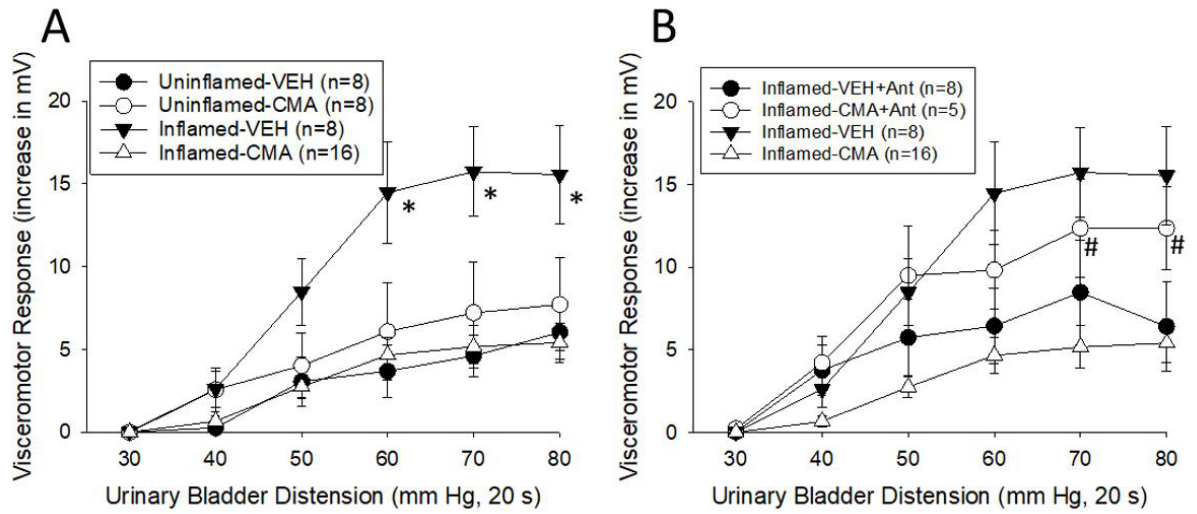
Figure 2. ( A ) Visceromotor responses to UBD in female rats with and without inflamed bladders after either intravesical vehicle (VEH) or cinnamaldehyde (CMA) infusion. * indicates a significant difference from all other groups ( p < 0.05). ( B ) Same data for rats with inflamed bladders as in ( A ) but, in addition, data from rats that also were pretreated with intravesical HC030031, a TRPA1 antagonist (indicated as +ANT). # indicates a significant effect of HC030031 pretreatment ( p < 0.05) at these intensities of UBD in CMA-treated